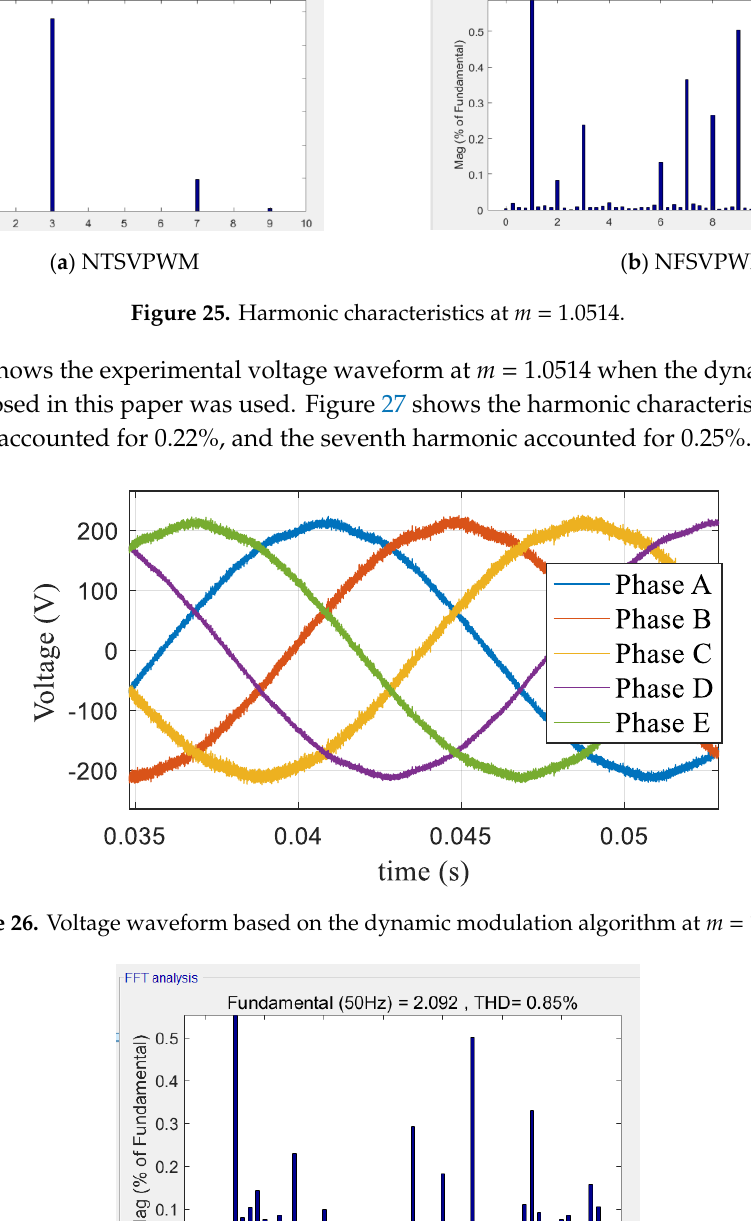
Figure 24. Voltage waveform based on traditional modulation at m = 1.0514.